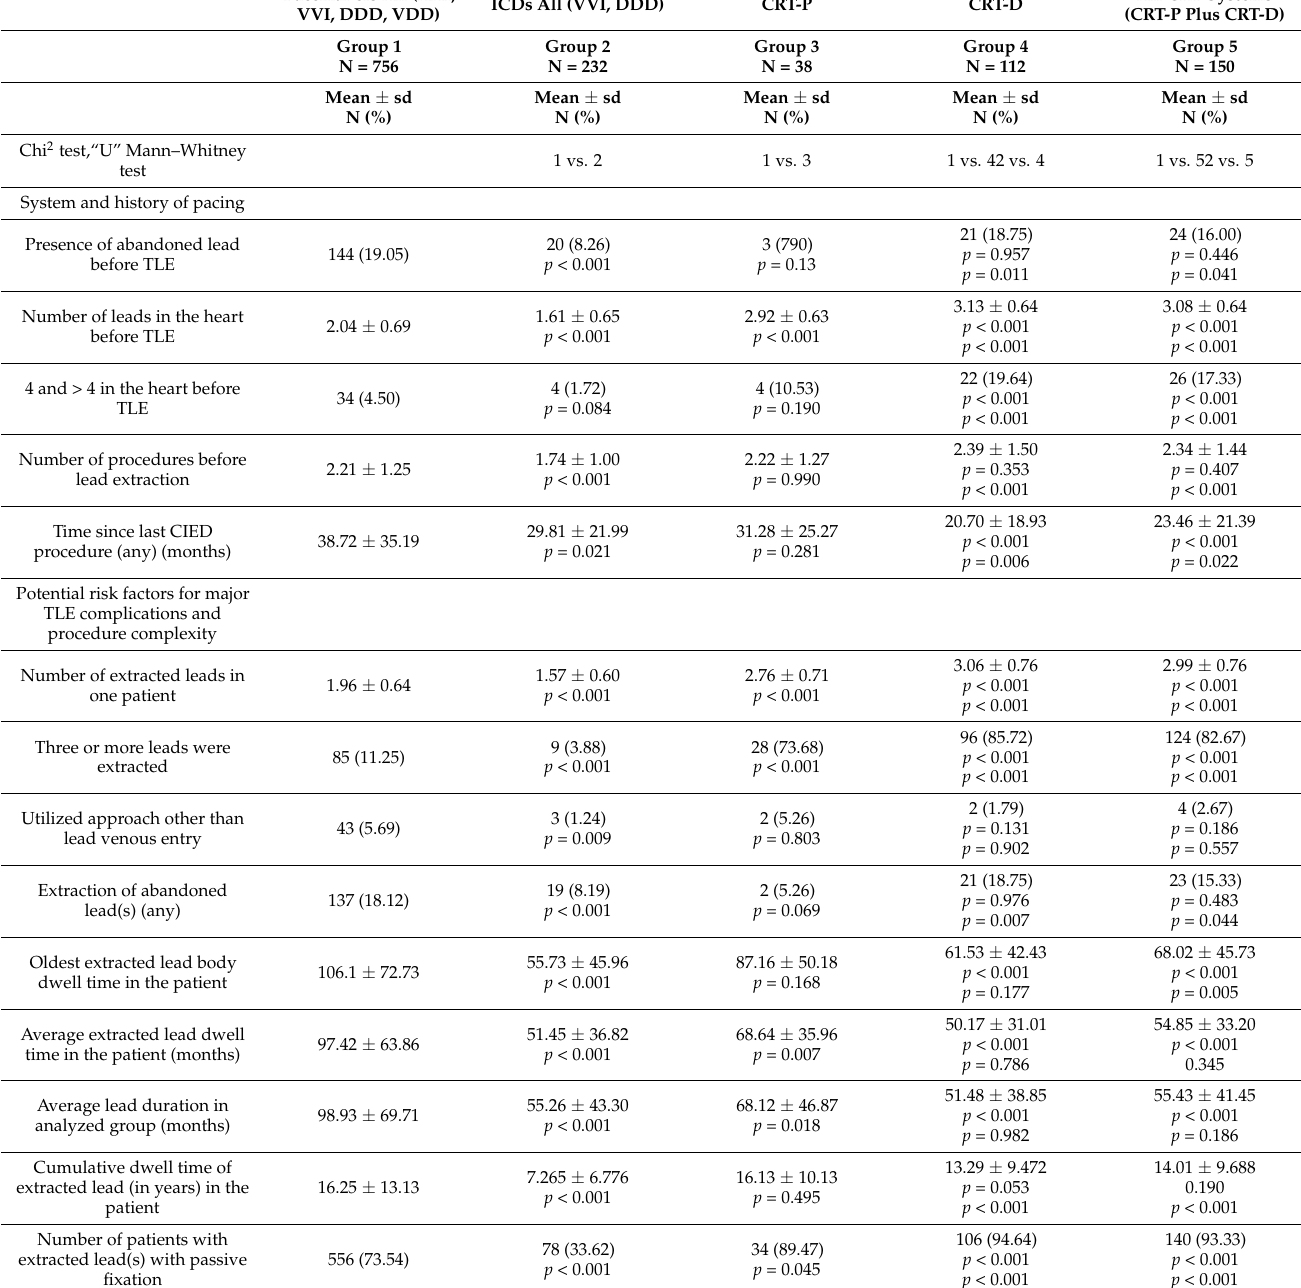
Table 3. System and history of pacing, TLE procedure and potential risk factors for major TLE complications and technical problems. Pacemakers All (AAI, VVI, DDD,